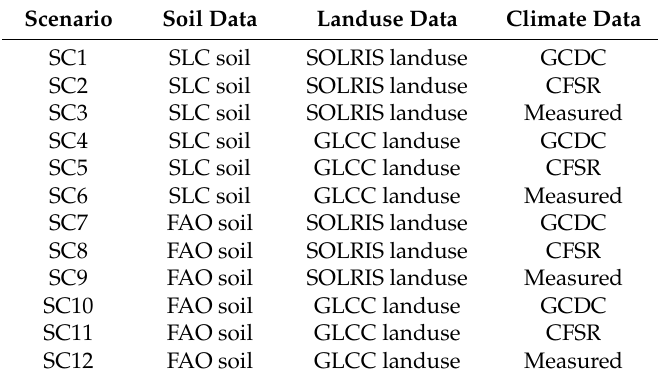
Table 2. Twelve scenarios developed in this